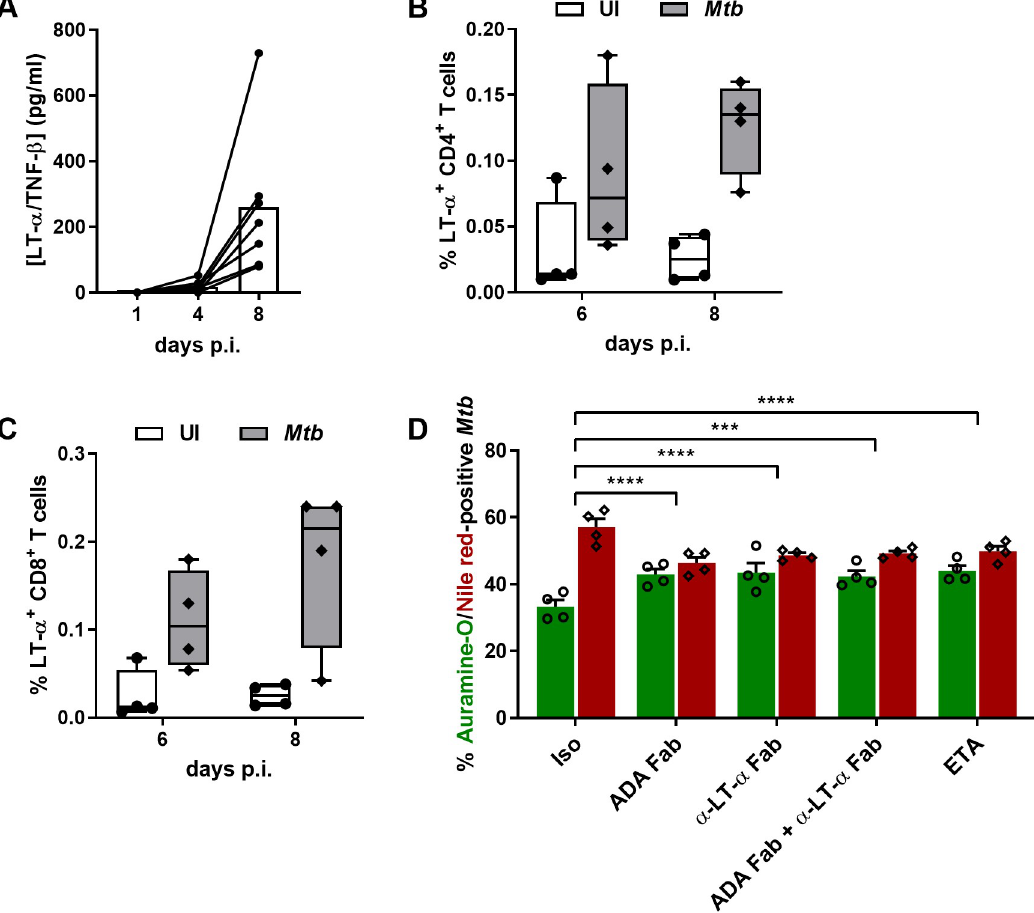
Fig 6. ETA-specific interference with CD4 + and CD8 + T cell-derived LT- α sustains mild Mtb resuscitation. (A) LT- α concentration in supernatants on days 1, 4 and 8 post-infection with Mtb H37Rv (values for 7 independent donors are represented by lined-connected circles and bars depict mean concentration). (B-C) Frequencies of LT- α -producing CD4 + (B) and CD8 + T cells (C) from uninfected PBMCs (UI) or granulomas 6 or 8 days post-infection with Mtb H37Rv (median with interquartile ranges, minimum and maximum values from 4 independent donors). (D) Percentages of auramine-O- (green) and Nile red-positive (red) Mtb quantified by fluorescence microscopy (mean ± SEM from 4 independent donors) after four days of exposure to either an isotype control (Iso), etanercept (ETA) or the Fab fragments from adalimumab (ADA-Fab) or an anti-LT- α antibody ( α -LT α -Fab). Statistical analysis was performed using a generalized linear mixed-effects model; ��� , p < 0.001; ���� , p <